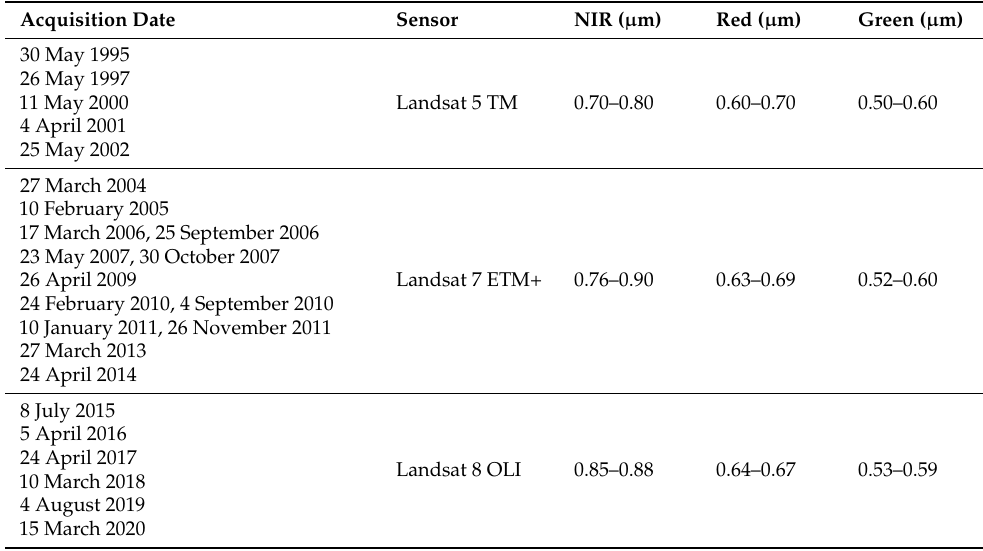
Table 1. Main specification of satellite imagery in the